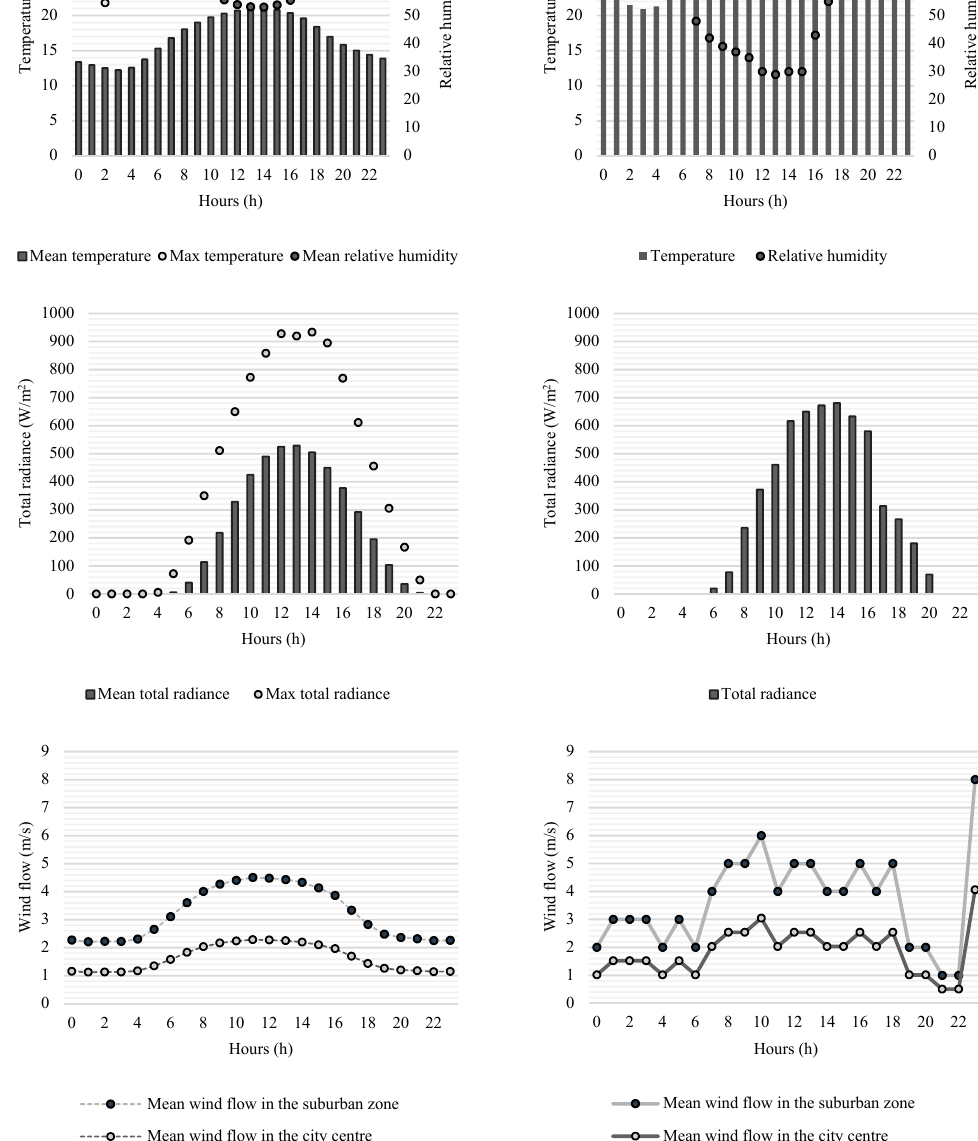
Figure 2. Basic meteorological parameters (warm period—left column; the hottest day of the year—right column).